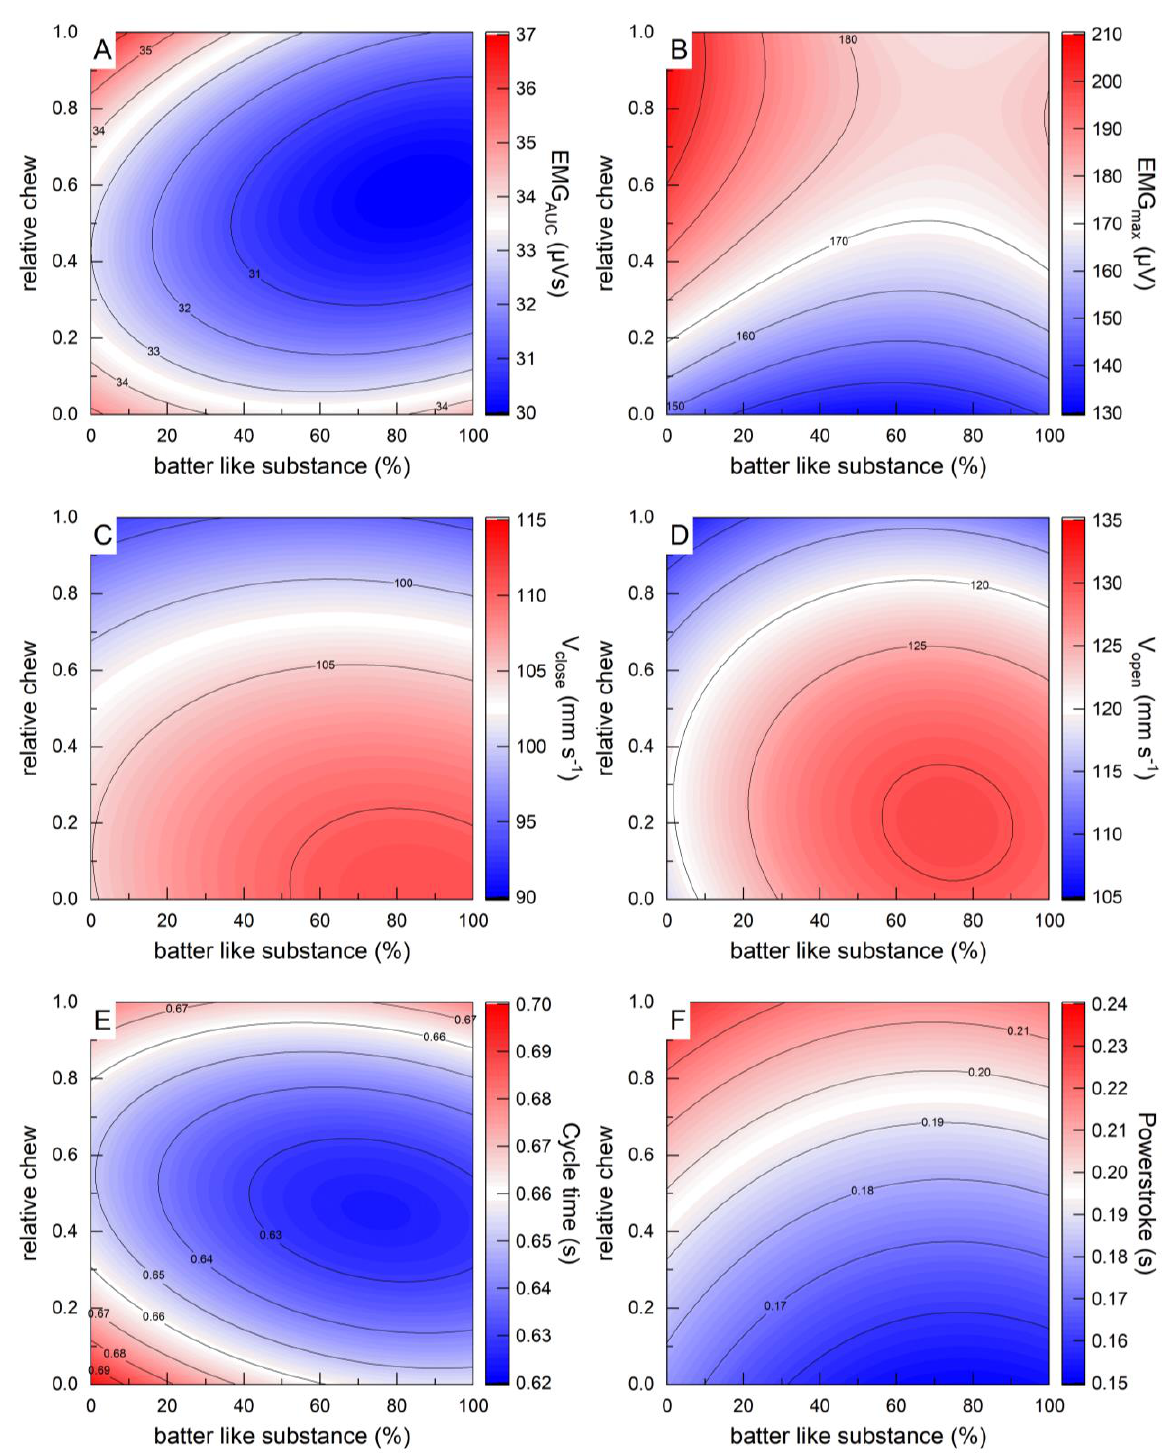
Figure 5. Illustration of the linear mixed model (Equation (1)) for integral of muscle activity ( A ), maximal muscle activity ( B ), opening- ( C ) and closing velocity, ( D ), cycle time ( E ) and duration of power stroke ( F ) as calculated in SAS for the variable of relative time over the sequence of mastication and amount of BLS in percent.